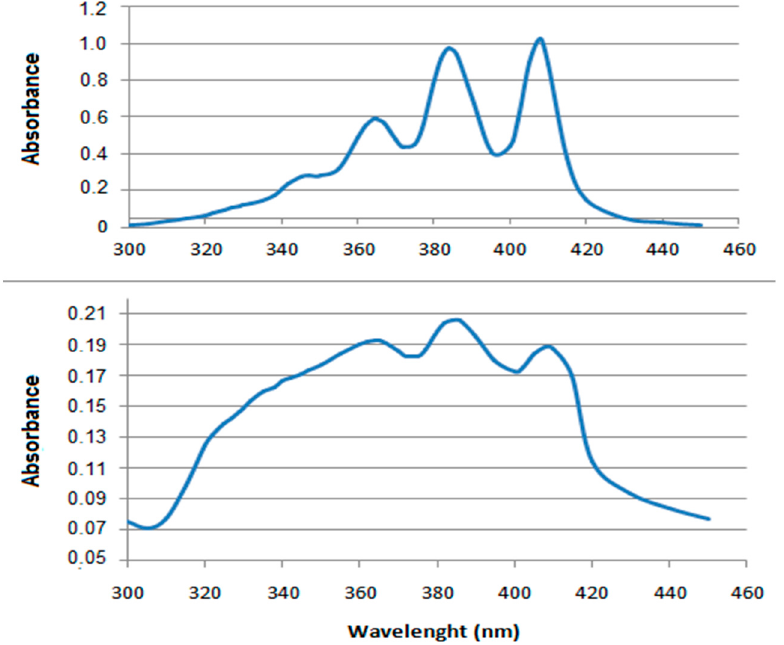
Figure 7. Spectra of electronic absorbance of AmB in MeOH:H 2 O (1:1) at 10 µg/mL ( top ) and solid dispersions of γ -cyclodextrin polymers and amphotericin B (100:20) at 10 µg/mL in deionized water ( bottom ).